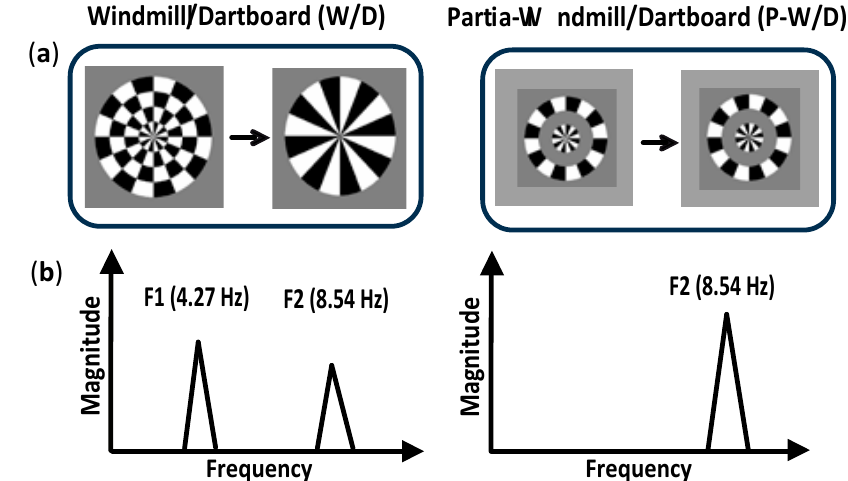
Figure 1. Schematic illustration of the paradigm used to investigate lateral interactions processing ( a ). In the Windmill/Dartboard (W/D) condition (left), the first and third rings (from the center to the outer edge) were static while the center and the second ring were contrast reversing at 4.27 Hz. In the Partial-Windmill/Dartboard (P-W/D) condition (right), only the center and second ring were presented dynamically. ( b ). Illustration of the predicted pattern of steady-state visual evoked potentials (ssVEPs) during the presentation of the W/D (left) and the P-W/D (right) stimuli. The W/D condition is expected to elicit a fundamental frequency or first harmonic (F1) larger than the second harmonic (F2). The second harmonic (F2) in the W/D is attenuated compared to the second harmonic (F2) obtained in the P-W/D. The fundamental frequency (F1) in the P-W/D is absent. Stimuli were presented on a gray background with a mean luminance of 13 cd/m 2 . Each stimulus presentation lasted 60 seconds and was shown twice in each condition (W/D and P-W/D). Visual